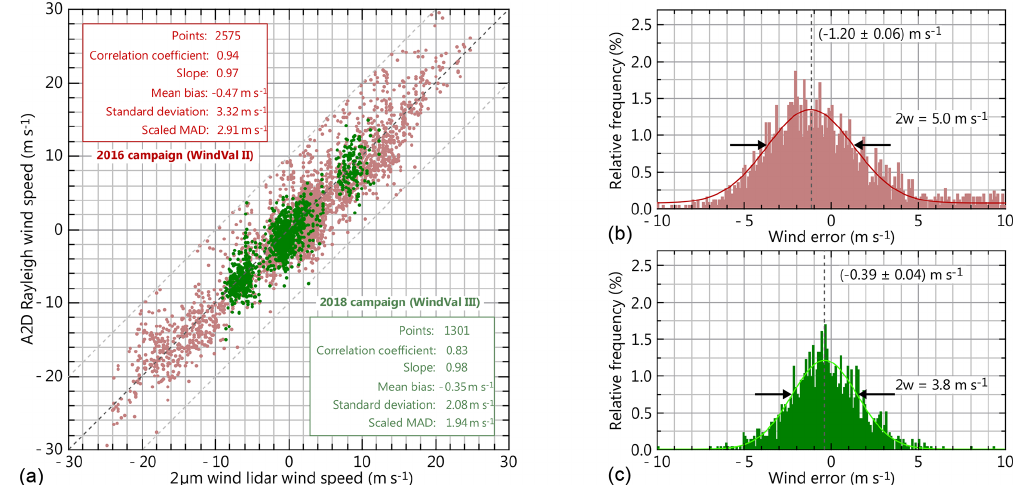
Figure 6. (a) Scatterplots comparing the A2D Rayleigh LOS winds with the 2µm DWL winds for all Aeolus underflight legs from the WindVal III campaign in 2018 (green) and for all flights from the WindVal II campaign in 2016 (red). The corresponding probability density functions for the wind differences (A2D–2µm), i.e. the A2D wind error, are shown in panels (b) and (c) for the two campaigns respectively. The solid lines represent Gaussian fits with the given centres and e − 1 / 2 widths 2 w